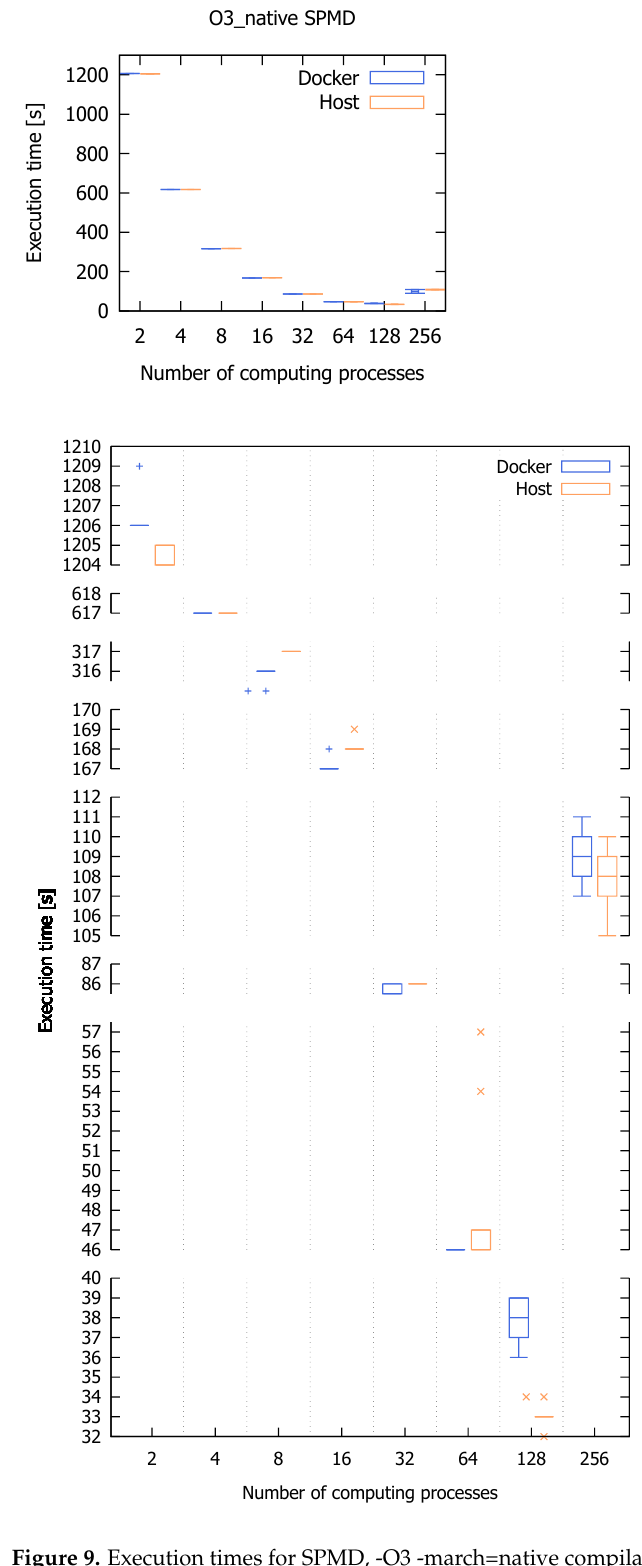
Figure 9. Execution times for SPMD, -O3 -march=native compilation flag; boxplot notation: medians, Q1 and Q3, max(Q1 − 1.5IQR, minimum) and min(Q3+1.5IQR, maximum) as well as potential outliers (+ for Docker, x for